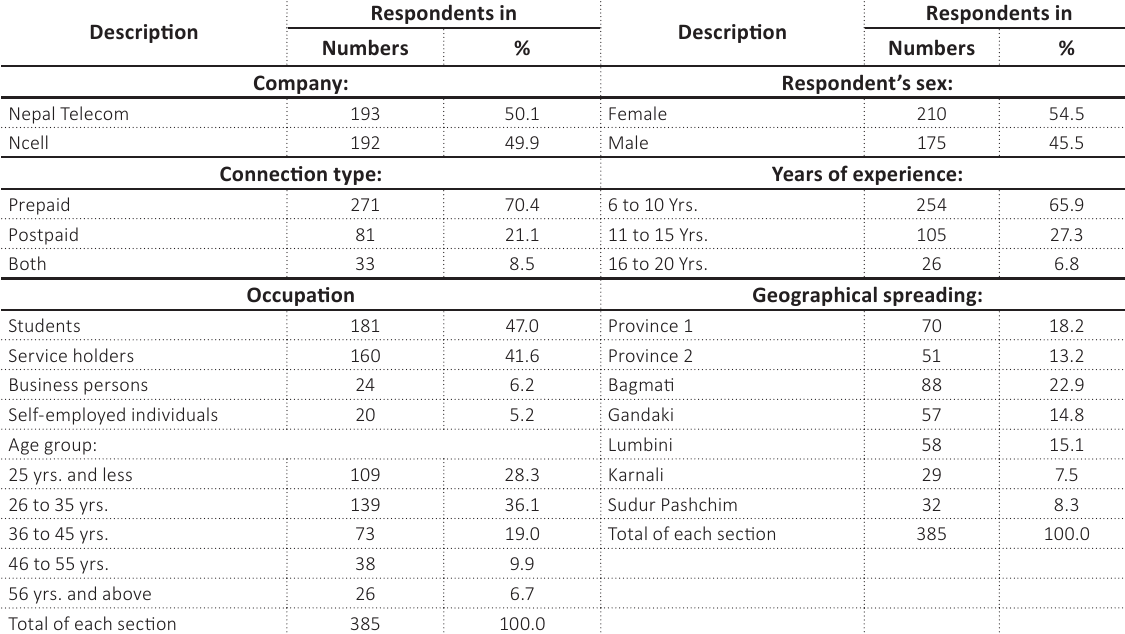
Table 1. General information on the